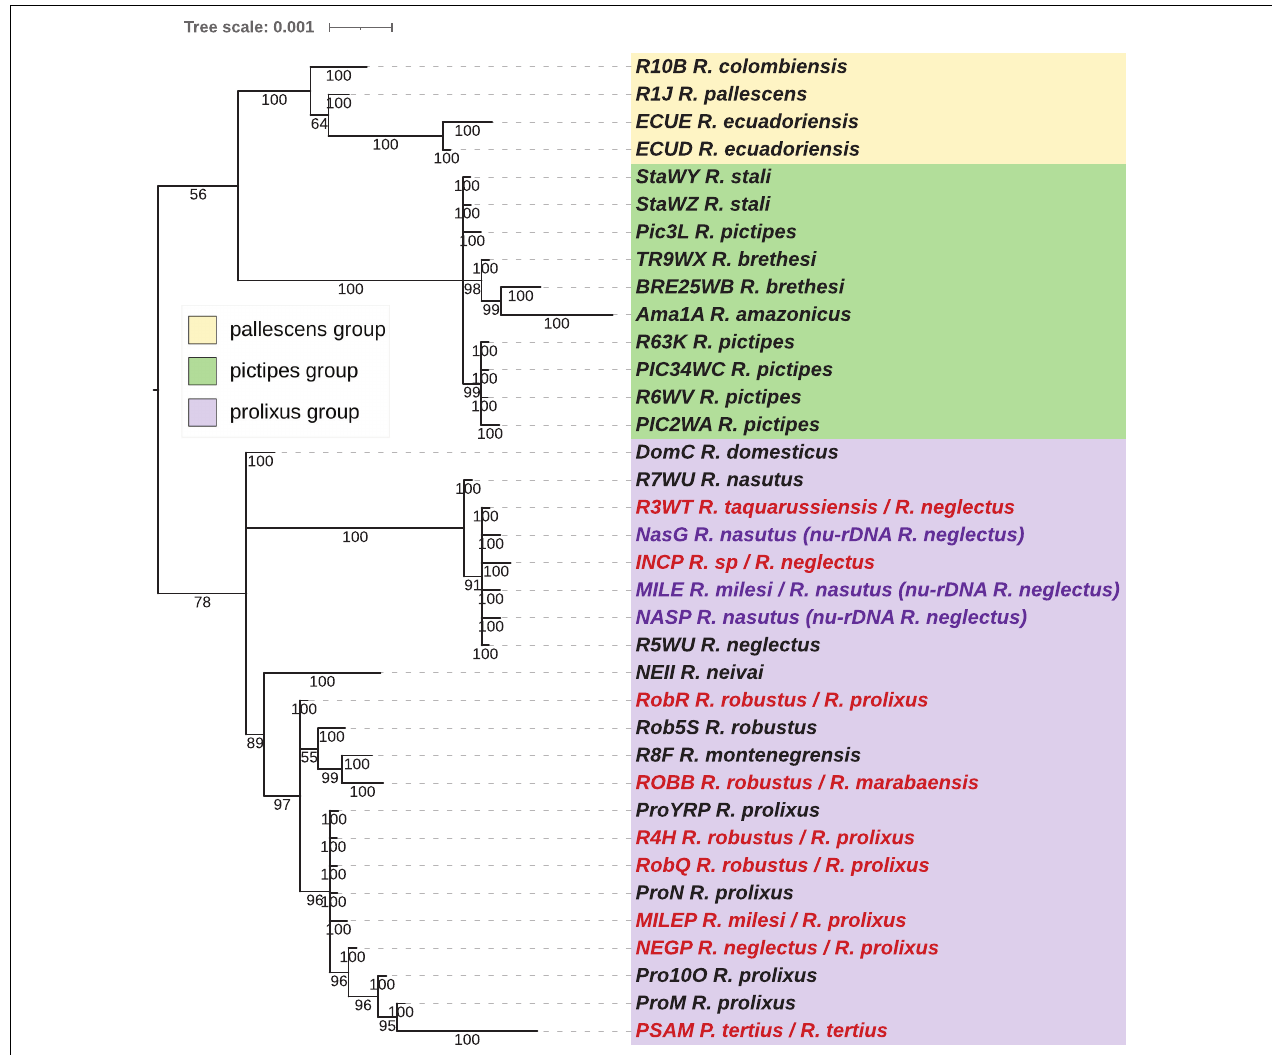
FIGURE 4 | Phylogenetic inferences for the concatenated nuclear rDNA (nu-rDNA) dataset for Rhodnius species using Bayesian Inference (BI) method. The statistical supports (specify Bayesian posterior probabilities in percent) are indicated on the branches. B. colossus was used as outgroup. Introgressed species inferred from the nuclear phylogeny (see Figure 5 ) are indicated in purple, and misidentified species in